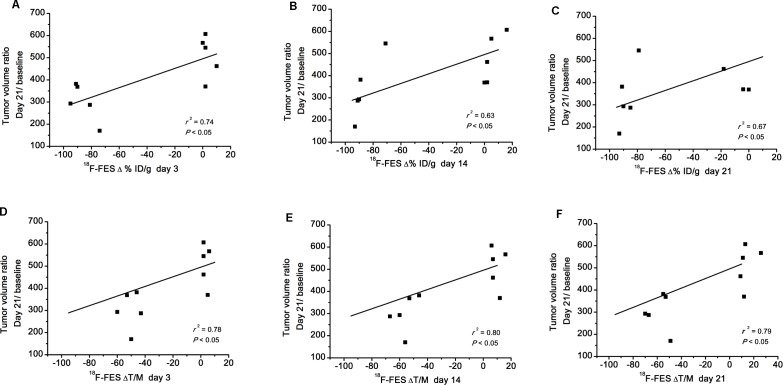
Correlation between tumor 18F-FES uptake and tumor growth.18F-FES Δ%ID/gmax and ΔT/M on day 3, day 14 and day 21 was significantly correlated with the day 21/baseline tumor volume ratio.